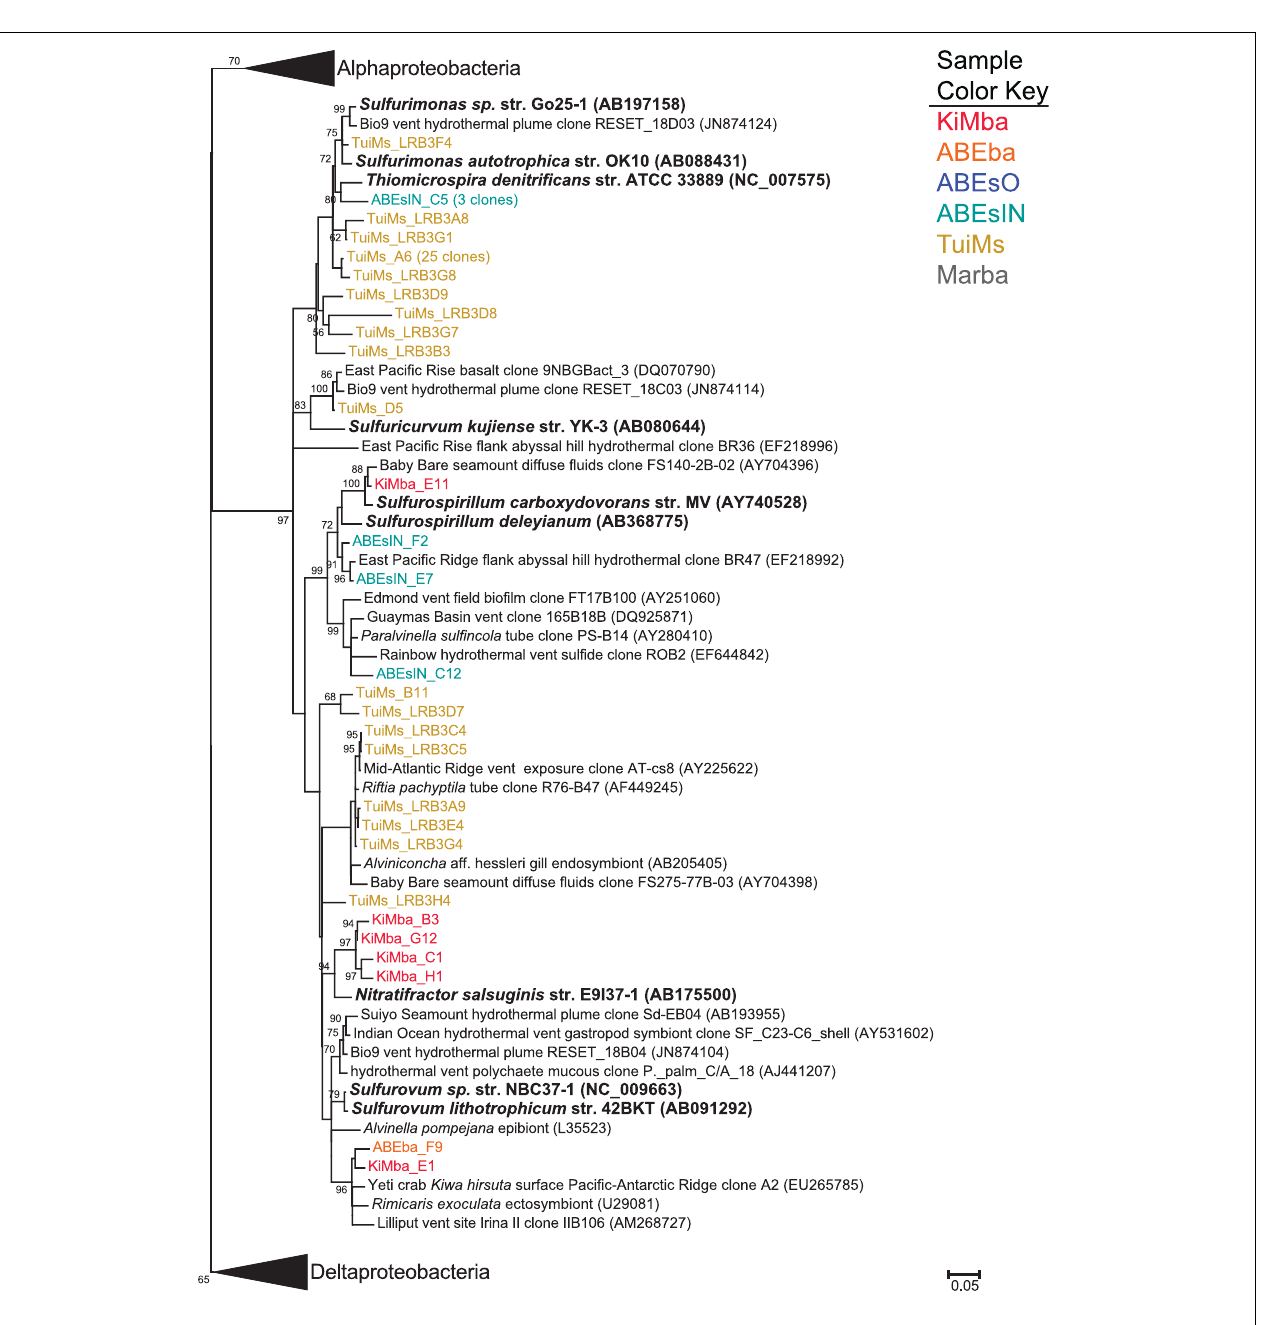
Jukes–Cantor model and a Gamma distribution and 500 bootstrap replicates. Nodes where bootstrap support is > 50% are indicated. Samples are color-coded and no representative clones are shared across multiple